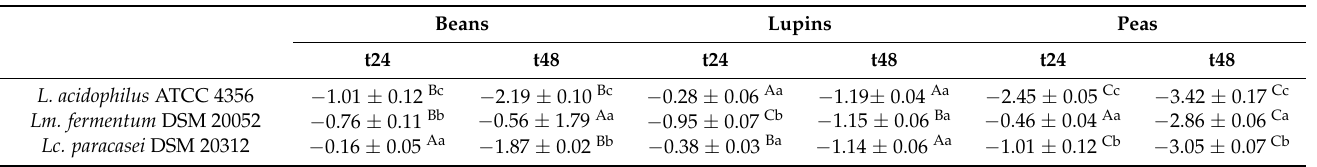
Table 5. Differences in pH values, reported as ∆ pH values after 24 and 48 h of incubation at 37 ◦ C, of legume grain water extracts inoculated with selected LAB strains.